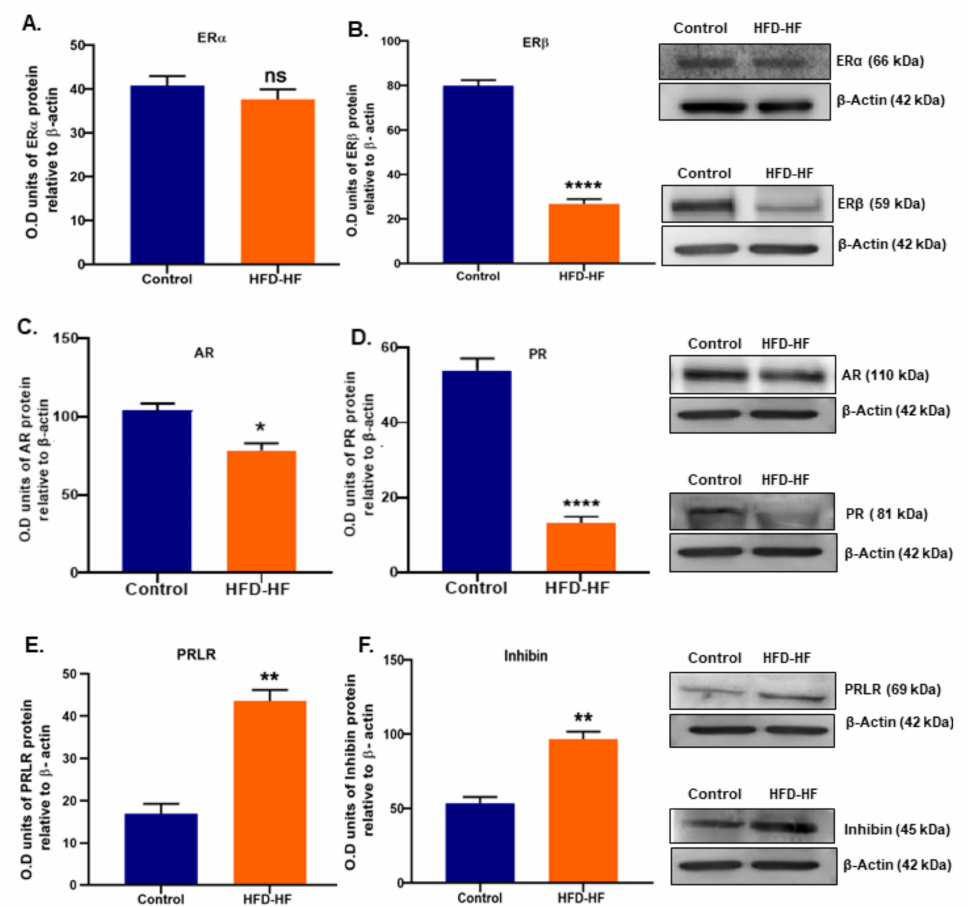
Figure 6. Effects of the HFD-HF diet on the expression level of ( A ) ER α , ( B ) ER β , ( C ) AR, ( D ) PR, ( E ) PRLR, and ( F ) Inhibin in the ovary of the adult rat. Each value is mean ± SEM of three samples of pooled cells from six animals in each group. Bars with ns denote the statistically insignificant differ- ences between the respective means, while those (*, **, ****) signs represent statistically significant differences (* p ≤ 0.05, ** p ≤ 0.01, **** p ≤ 0.0001 vs. control group) between the respective